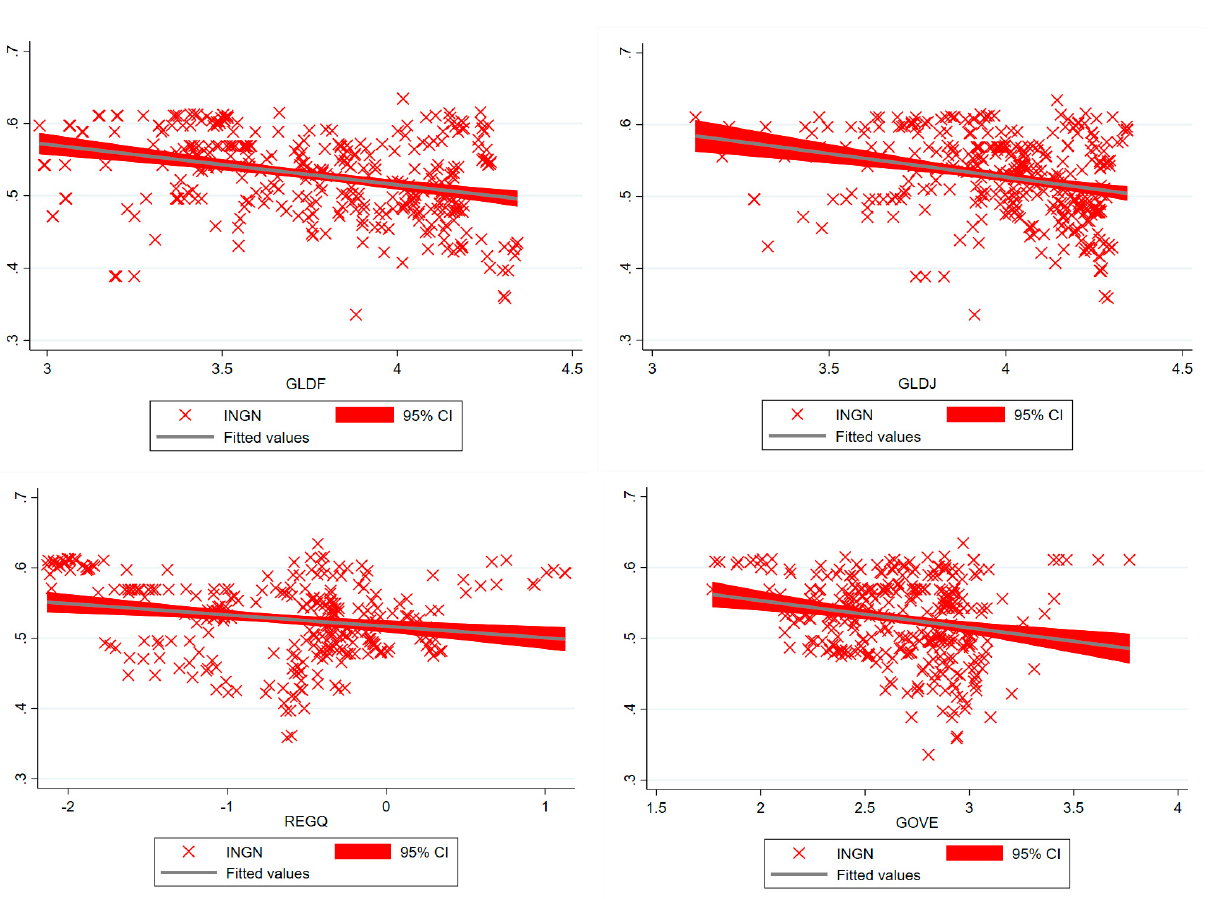
Figure 1. Fitted values for income inequality and globalization dynamics Note: CI—Confidence Figure 1. Fi tt ed values for income inequality and globalization dynamics Note: CI—Con fi dence in- terval. Legend: INGN—Income inequality Gini coe ffi cient, GLDF—Globalization de facto; GLDJ— interval. Legend: INGN—Income inequality Gini coefficient, GLDF—Globalization de facto; GLDJ— Globalization de jure . Globalization de